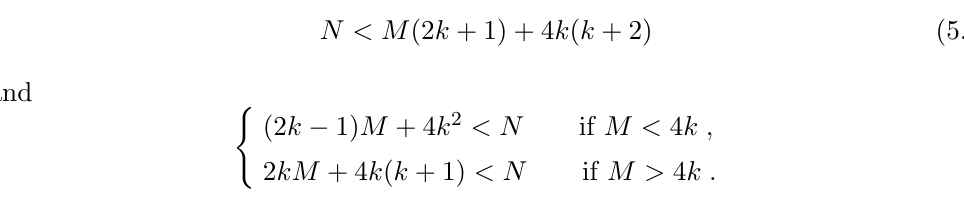
Figure 33. The theory at the end of the duality cascade of ( C = Z 0 is performed before the